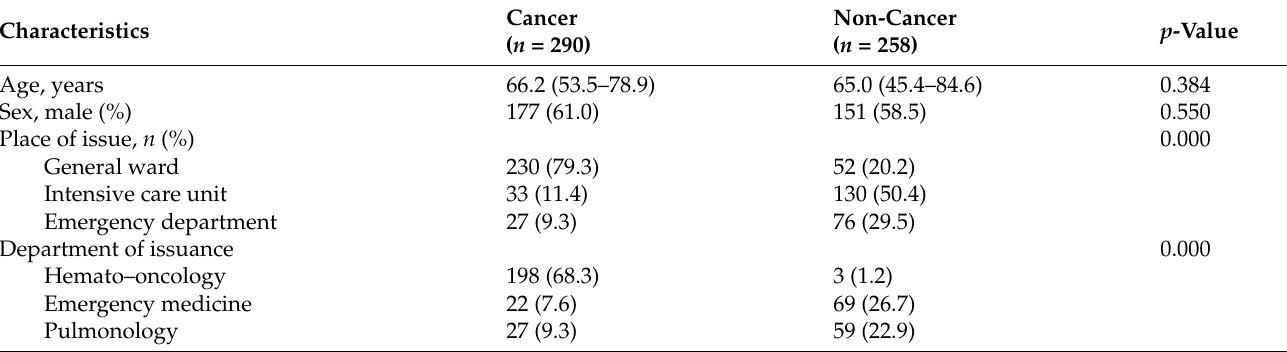
Table 4. Characteristics of death certificates according to cancer